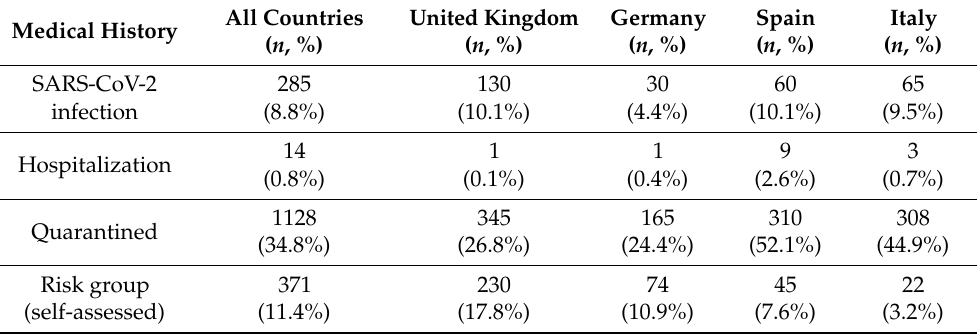
Table 1. COVID-19-related medical history ( N = 3251 after excluding ineligible